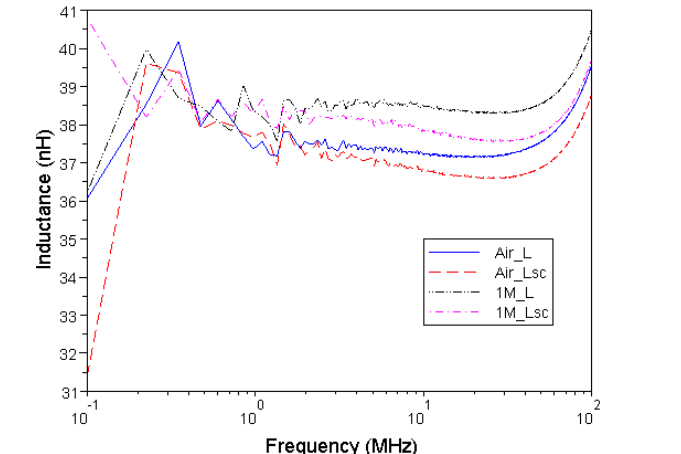
) of coils of MEMS sc O 3 4